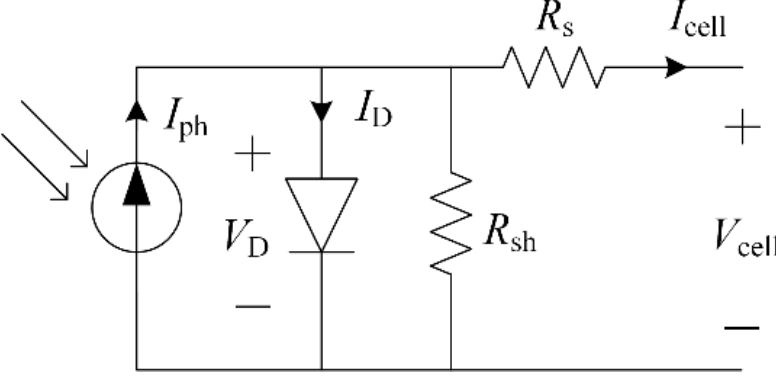
Figure 5. Solar cell equivalent circuit. Therefore, when the temperature is constant, the U-I characteristic curve of a solar cell varies with the light intensity, as shown in Figure 6. The short-circuit current increases with the light intensity, and there is a good linear relationship under strong light.